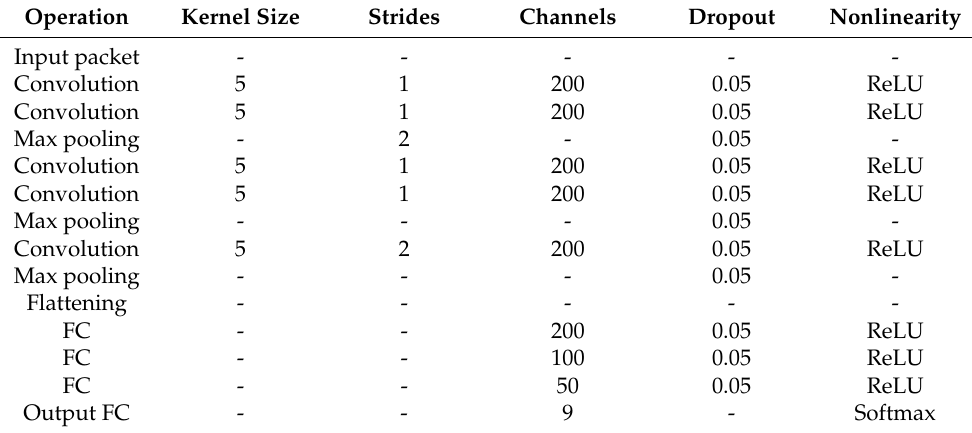
Table 3. Network hyperparameters.